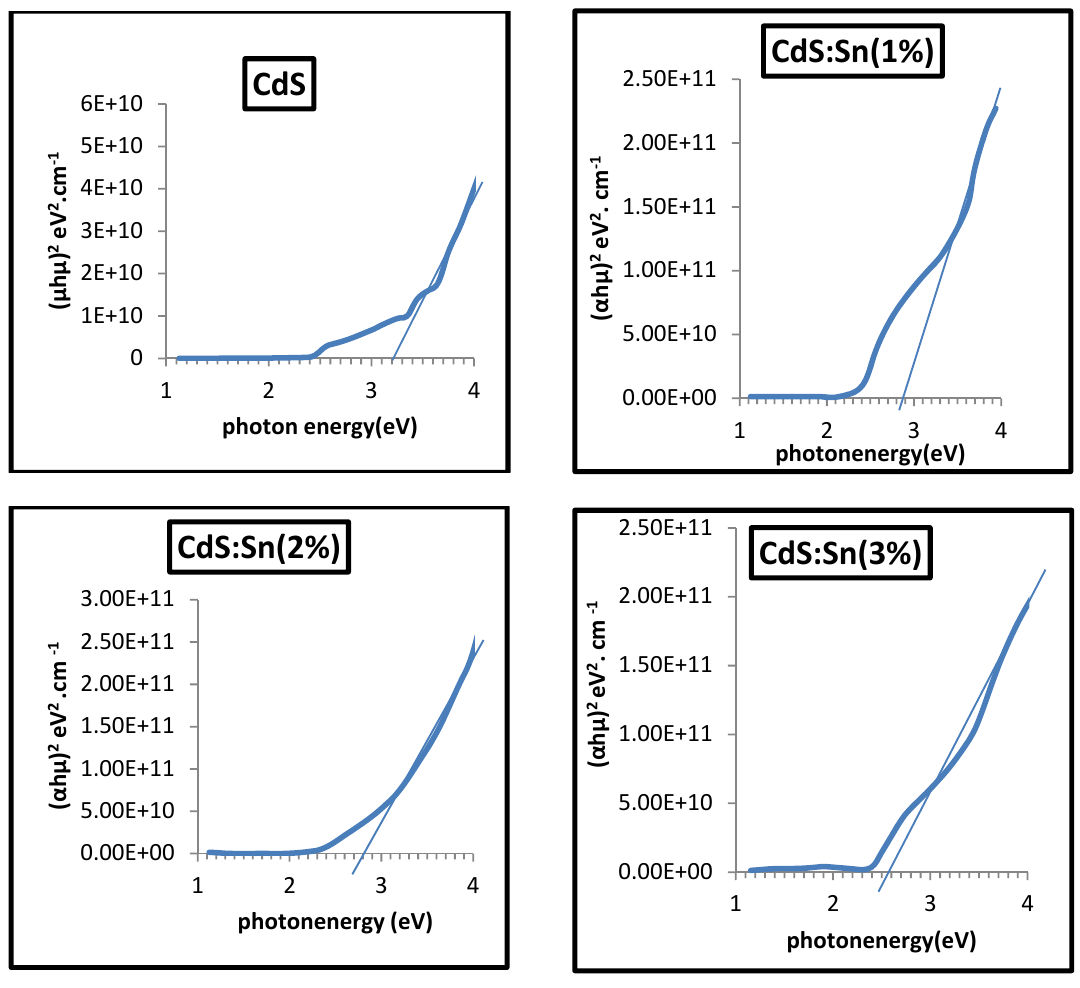
Fig. 5: ( α h υ ) 2 as a function of h υ for CdS and CdS:Sn thin